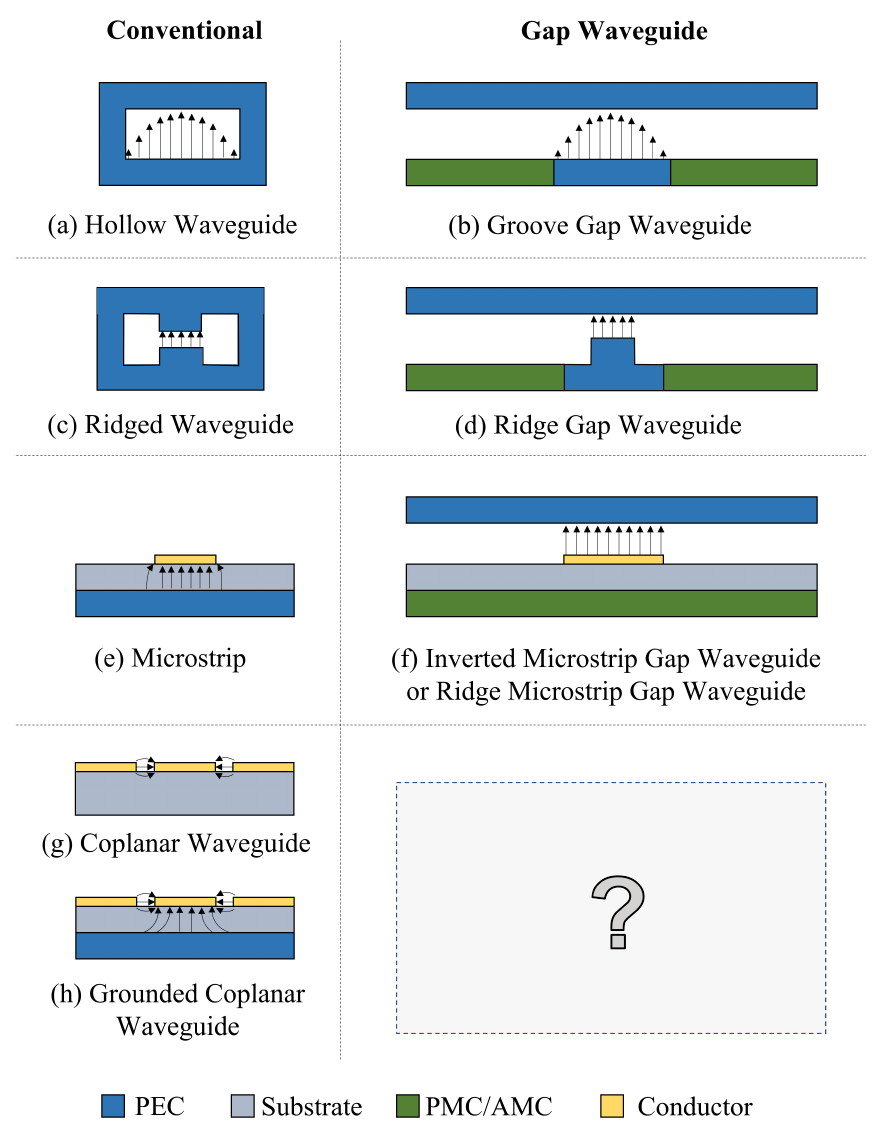
Figure 1. Summary of the typical transmission lines and waveguides together with their “Gap Waveguide” counterparts. E-field lines of the dominant mode are also plotted for each case. Blank spaces are considered air/vacuum.